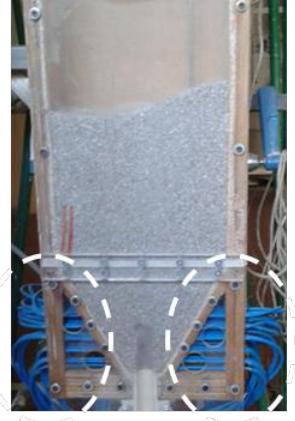
Figure 2. Spout-fluid configuration.